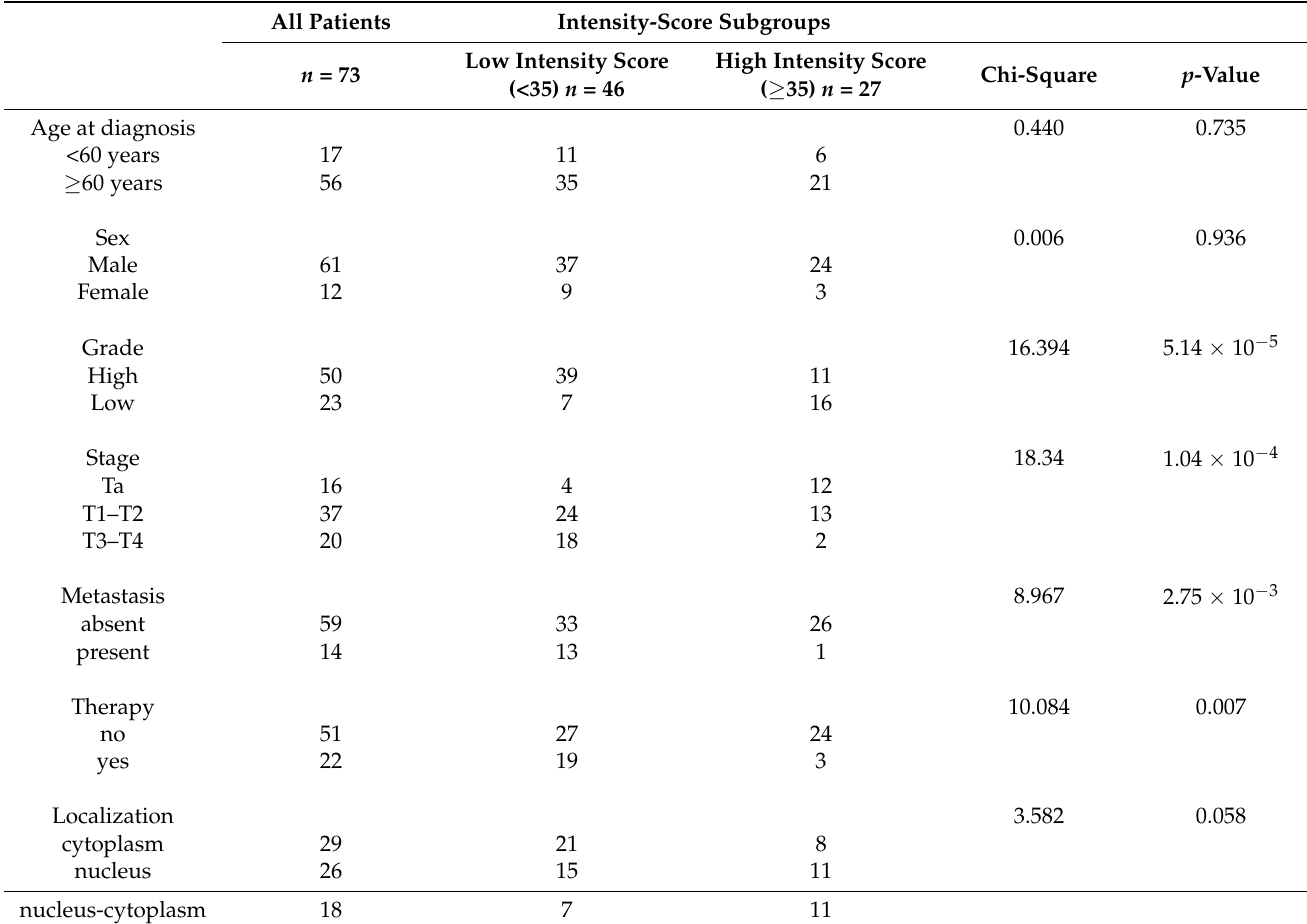
Table 1. Correlation between uc.8+ expression and clinicopathologic features of bladder cancer pts. All Patients Intensity-Score Subgroups Low Intensity Score High Intensity Score n = 73 Chi-Square p -Value (<35) n = 46 ( ≥ 35) n = 27 0.440